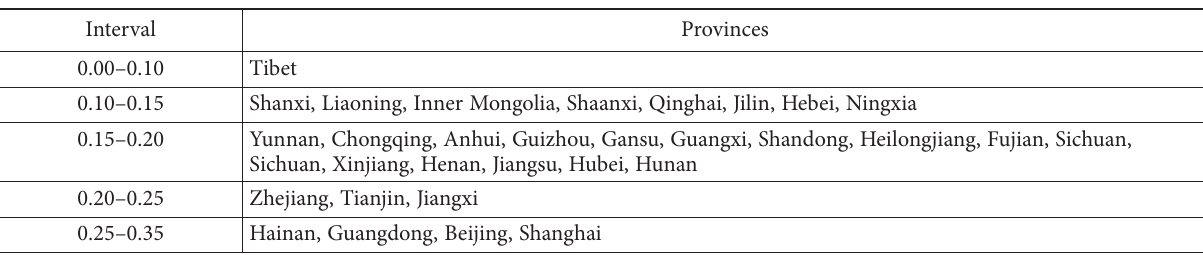
Table 4. The five intervals of the overall